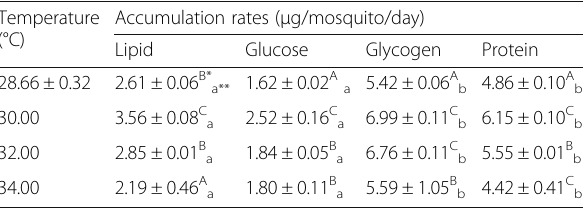
Table 7 Effects of rearing-water temperature on accumulation rates of teneral reserve in Culex quinquefasciatus mosquito Temperature (°C)